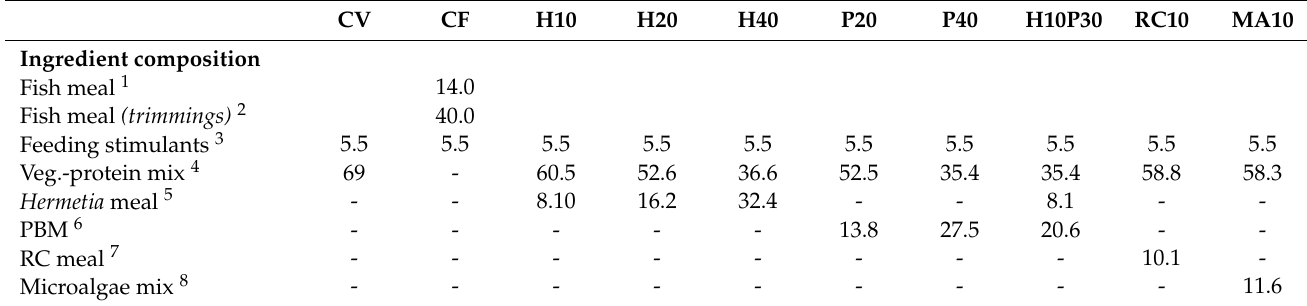
Table 1. Ingredient (g 100 g − 1 ) and chemical composition (% as feed) of the experimental diets.